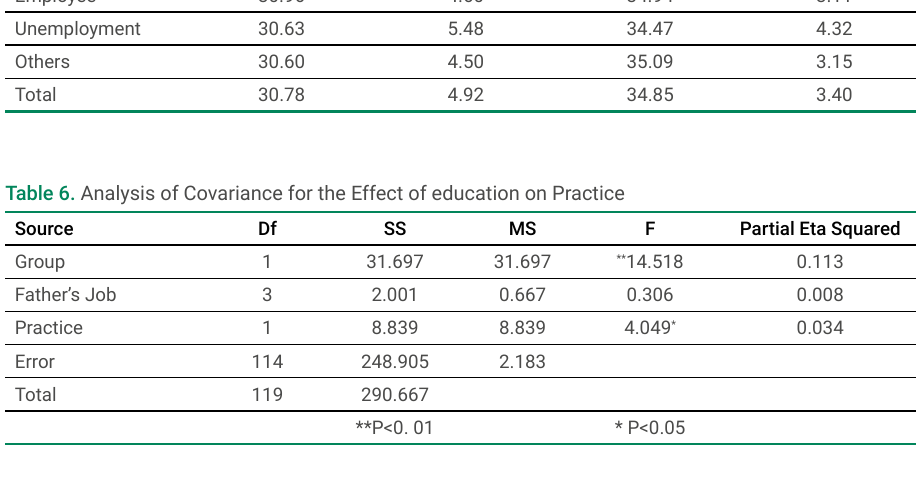
Table 5. The mean and standard deviation of attitude scores after intervention in terms of education type and father’s job TLE PLE Father’s Job M SD worker